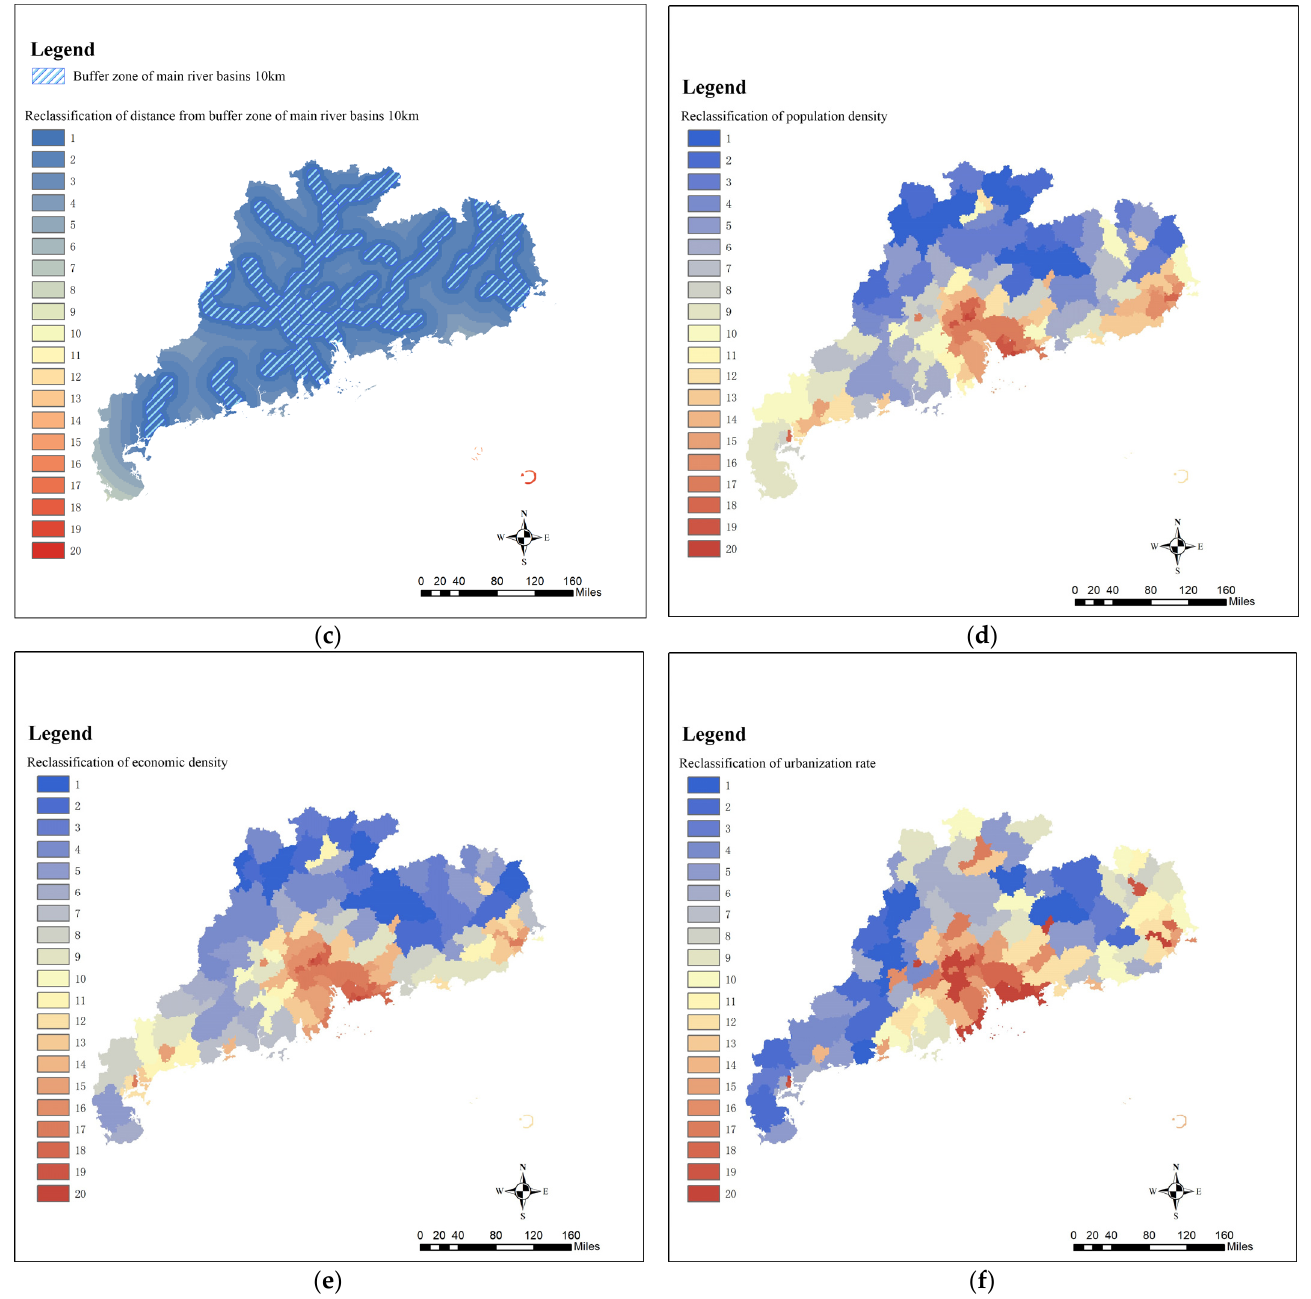
Figure 15. ( a ) 5 km × 5 km sampling points for environmental factors; ( b ) Reclassification of distance from range of mountain ranges; ( c ) Reclassification of distance from buffer zone of main water systems 10 km; ( d ) Reclassification of population density; ( e ) Reclassification of economic density; ( f ) Reclassification of urbanization rate.